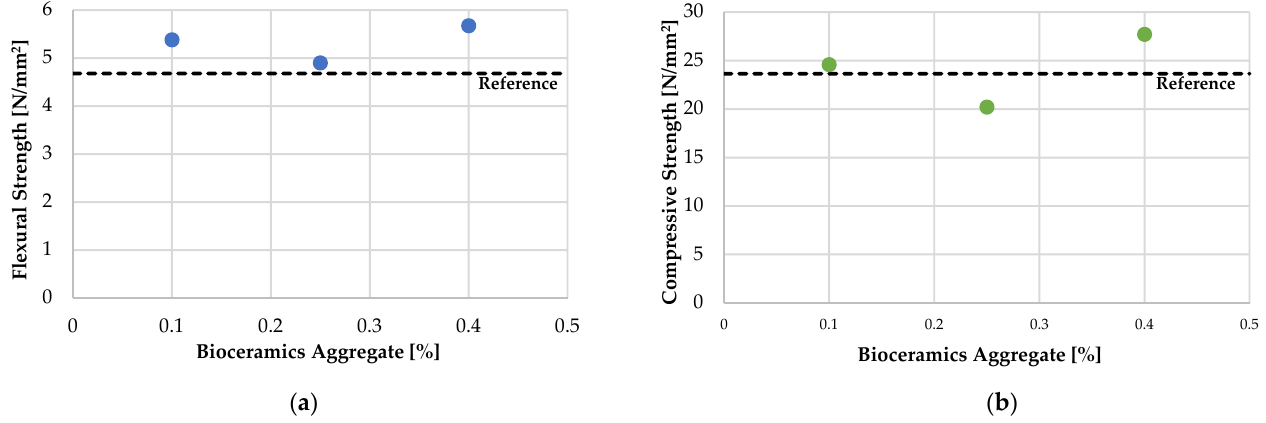
Figure 10. Mechanical properties of cement mortars ( a ) Flexural strength results; ( b ) Compressive strength values.